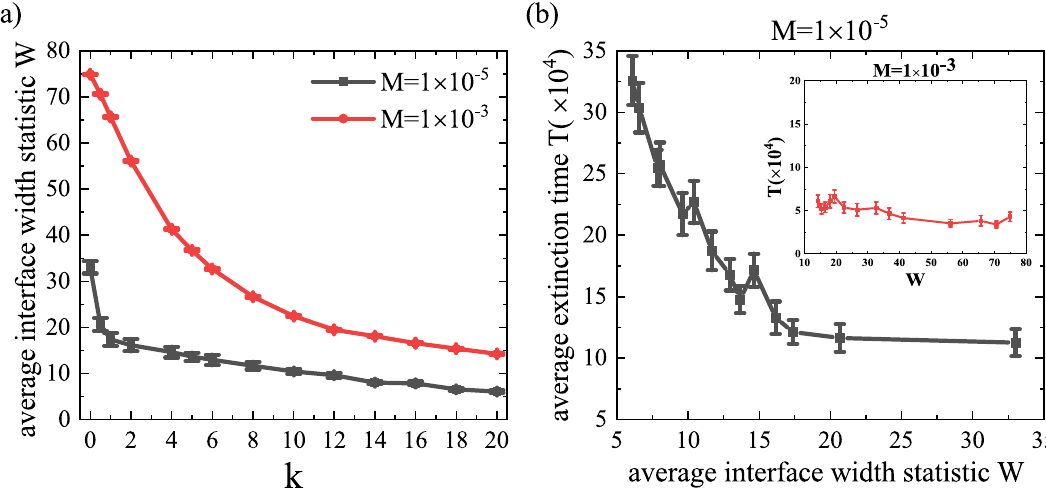
Figure 6. The evolution of interface width statistics at time step t = 1000 . ( a ) The average interface width statistic W as a function of k for two fixed mobility values. For two mobility values, we have a common feature that the value W is decreasing as k increases. In this case, the decrease in W shows a sharp change at the low M compared to the case of high M . Such a decrease shows a gradual change in the value of k above a certain level, and the decrease in W means that intraspecific interaction according to territorial awareness is eventually limited to the vicinity of the boundary between two domains. ( b ) Relationship between mean extinction time T and interface width statistic W for two fixed mobility values (see the illustration for M = 1 × 10 − 3 ). The relevant values correspond to the results shown in Figs. 3a, 6a with different values of k . The mean extinction time decreases with the interface width, which is more obvious at low migration rate and more gentle at high migration rate. The results were averaged from 30 independent simulations, and error bars (using standard errors, which defined as the sample standard deviation divided by the square root of the number of samples) are shown in the